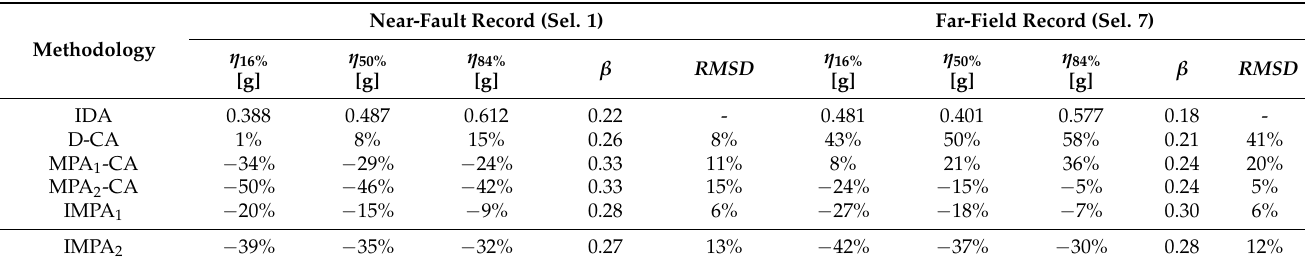
Table 4. Percentage values represent the percentage change with respect to the values observed for